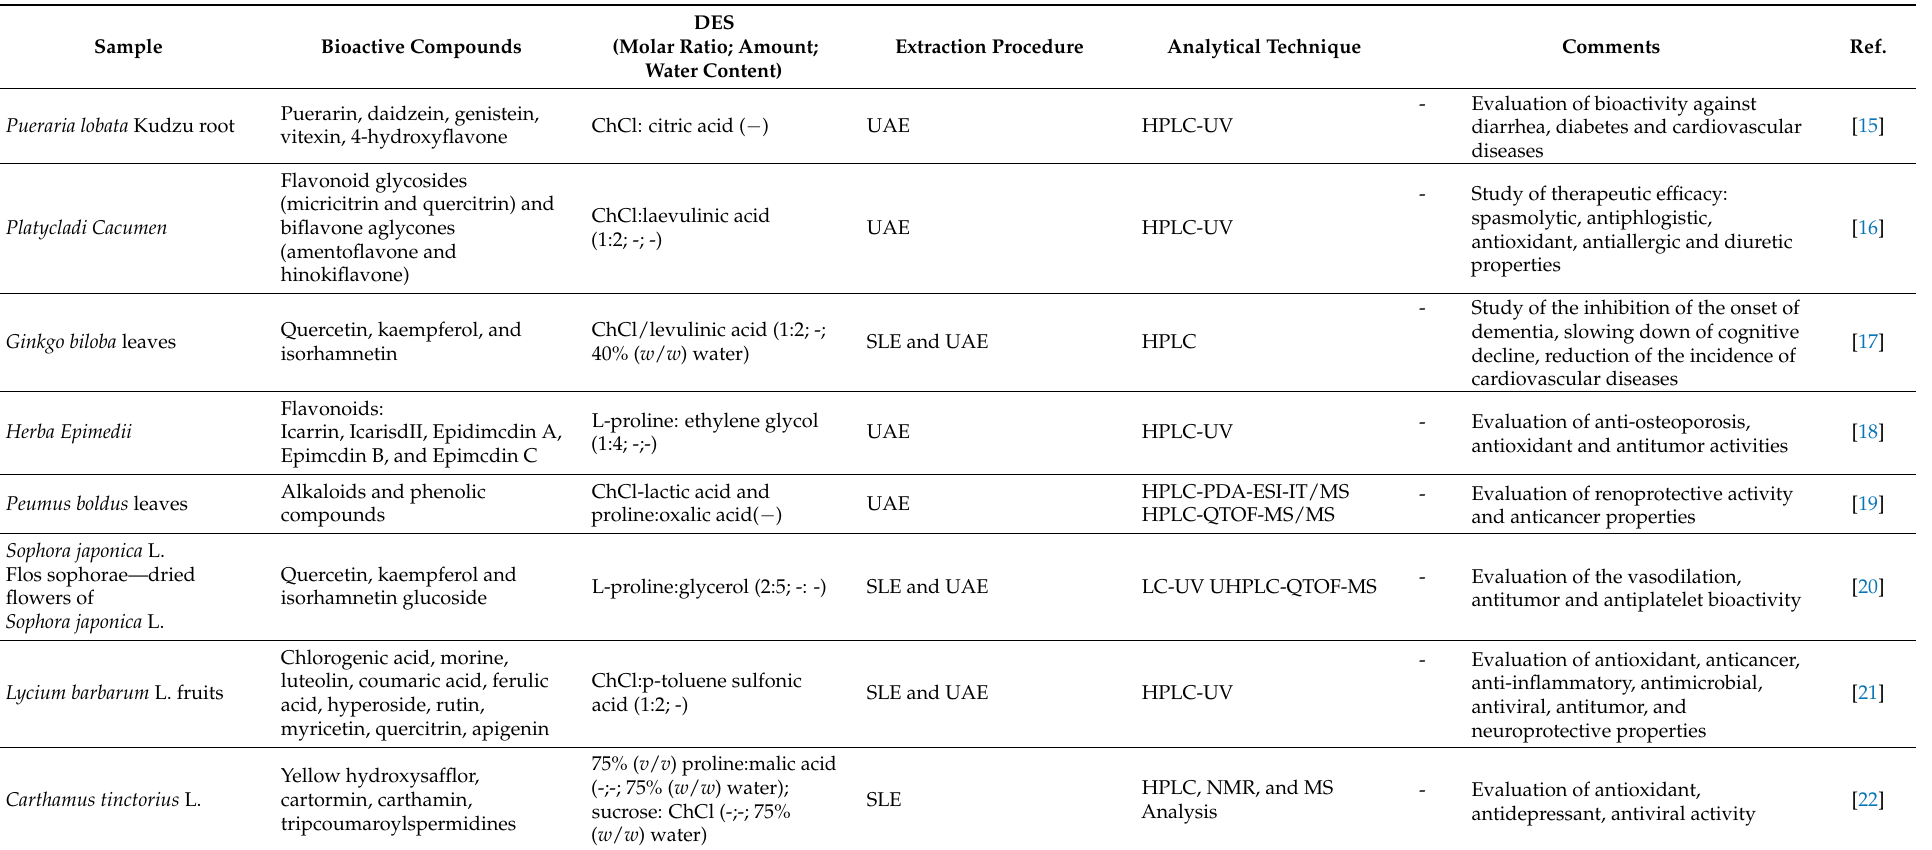
Table 1. Some examples of recent applications of DESs for the extraction of bioactive compounds from plants, fruits and